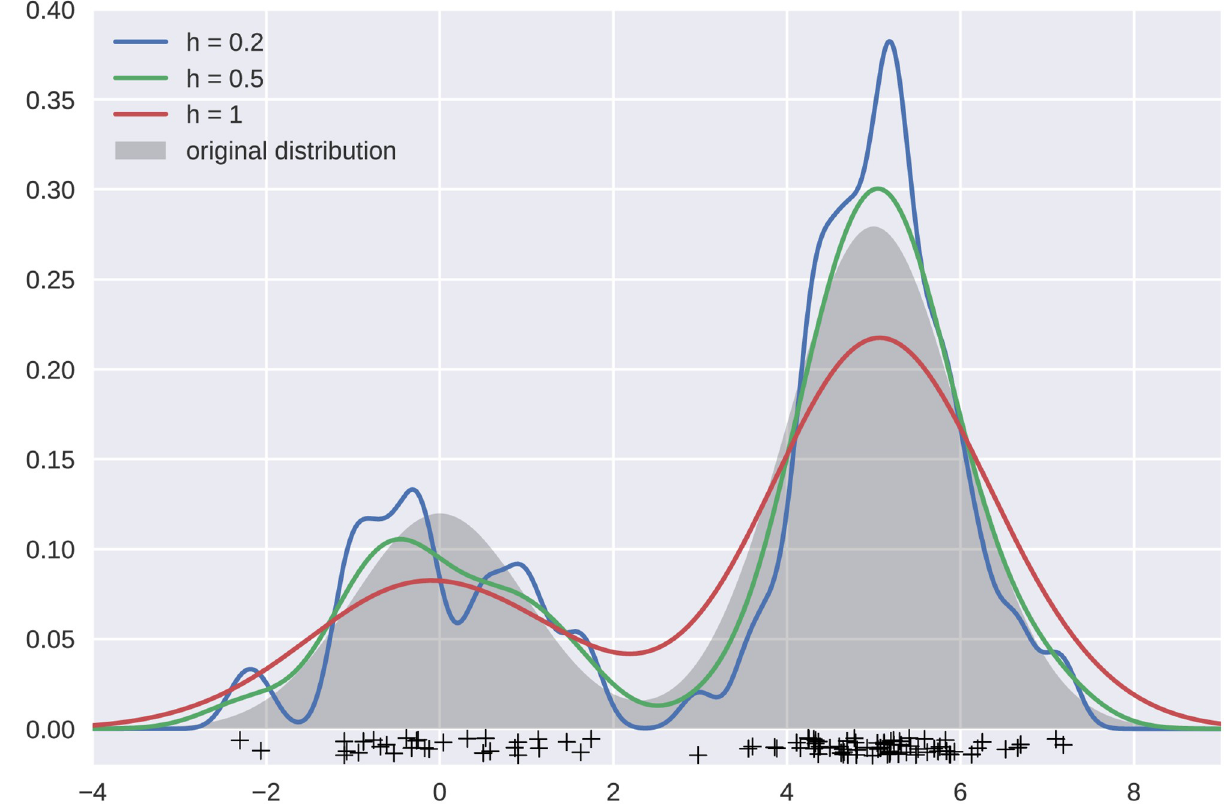
Fig 2. 1D kernel density estimate of a Gaussian distribution using various bandwidth